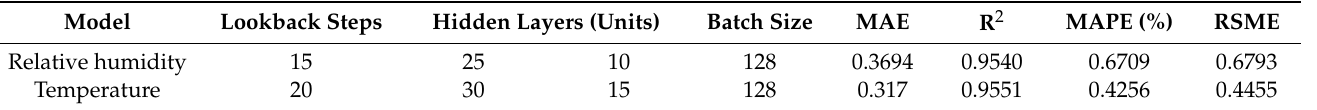
Table 4. Hyper-parameters and the validation metrics for the relative humidity and temperature models.